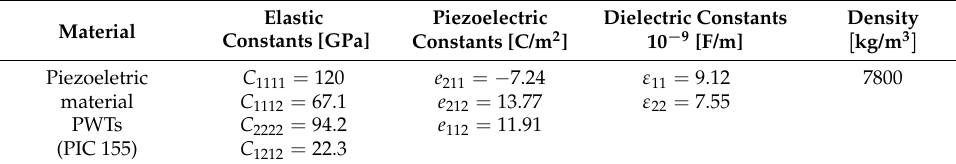
Table 3. Material properties of PWT.